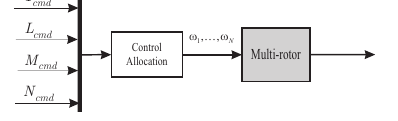
Figure 2: Control allocation